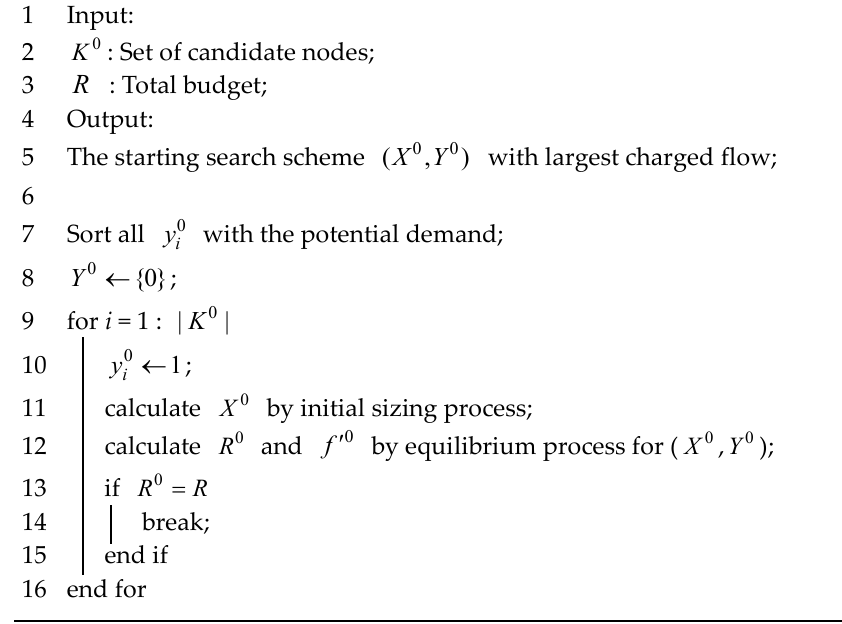
Algorithm 2 . The pseudo-code of Step 1.